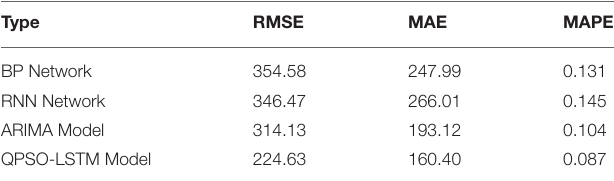
TABLE 4 | Accuracy comparison of different